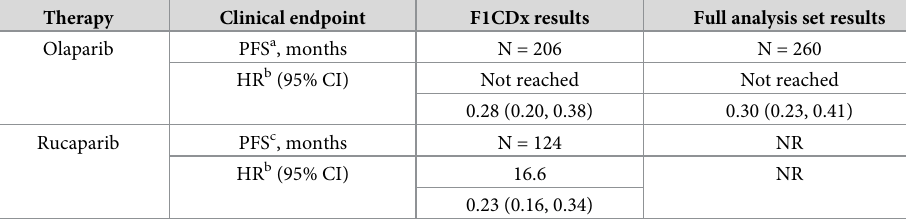
Table 5. Clinical utility of F1CDx for BRCA1/2 alteration companion diagnostic